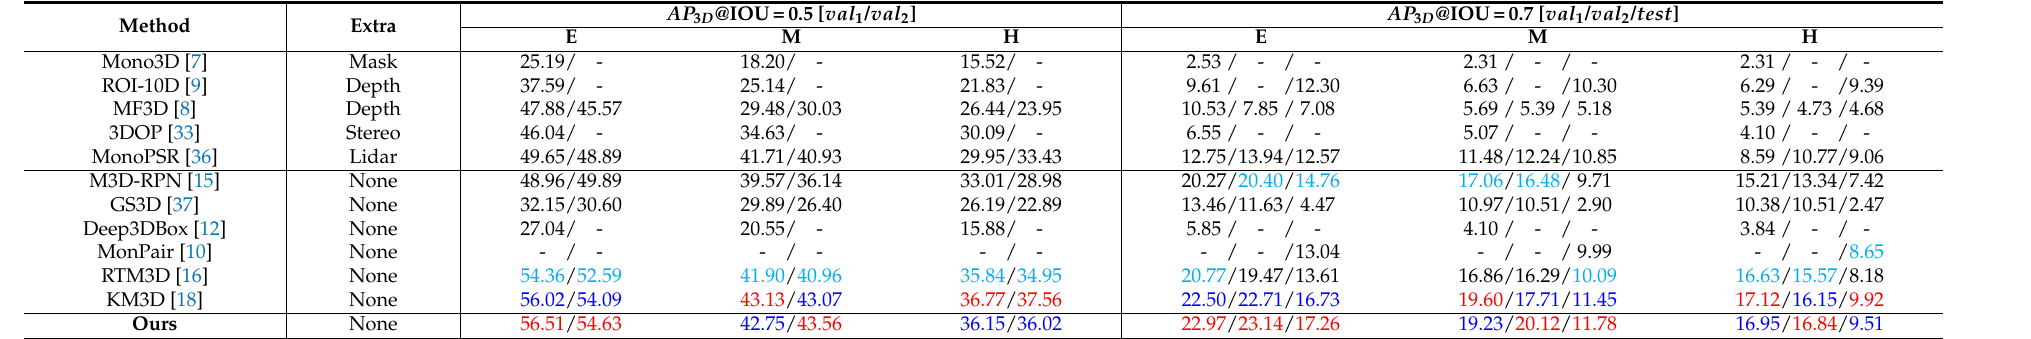
Table 1. AP 3 D comparison on val 1 , val 2 and test with a 0.5 and 0.7 IOU threshold: (a) Extra indicates whether there is additional information to assist detection (b) E, M and, H indicate the levels from Easy, Moderate, to Hard. (c) The red, blue, and cyan denote the highest, second highest, and third highest results respectively.